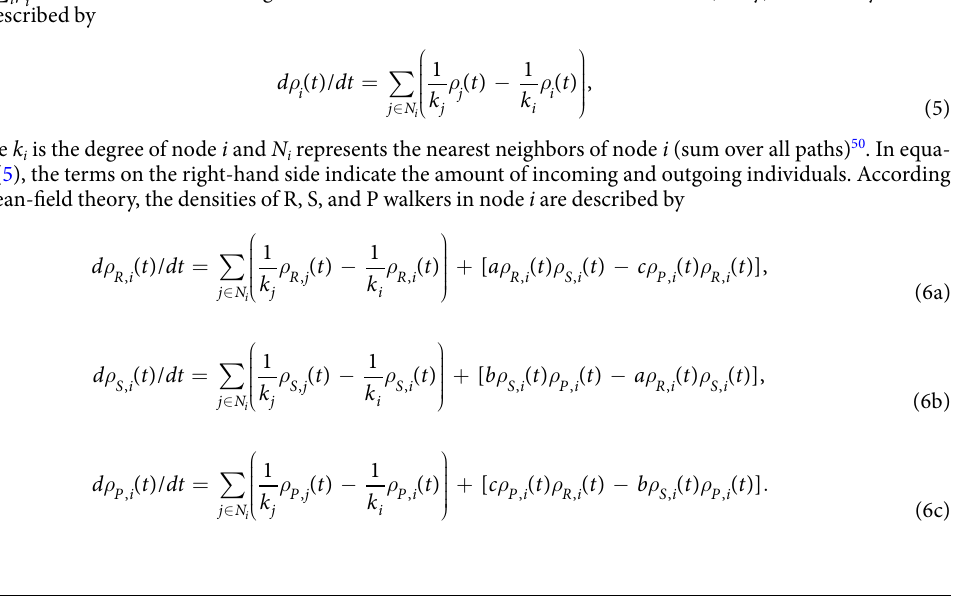
. Provided that the migration rate for all individuals take the same value (unity), the density in node i is described by